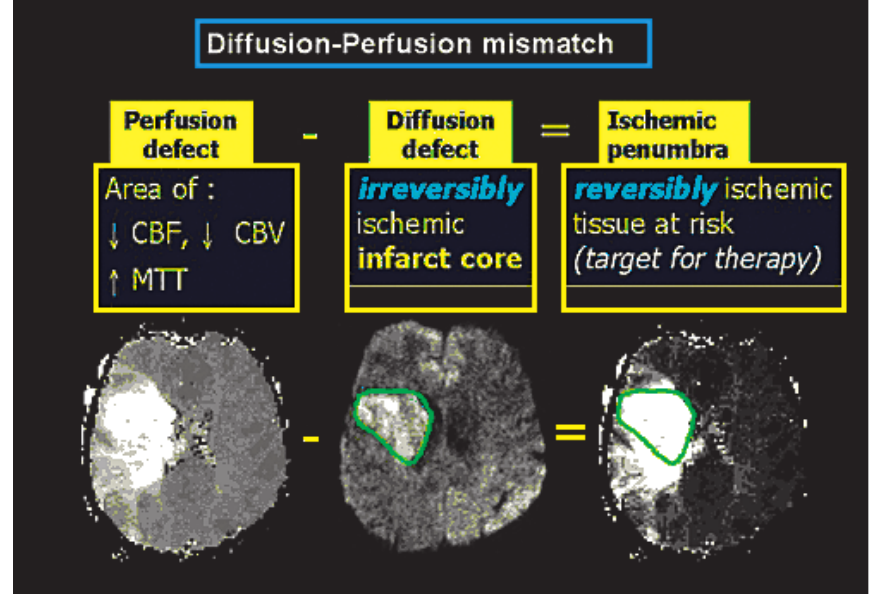
The mismatch concept. The central diffusion area is subtracted from the hypoperfused area’s volume; the periph- ery corresponds to the potential penum-